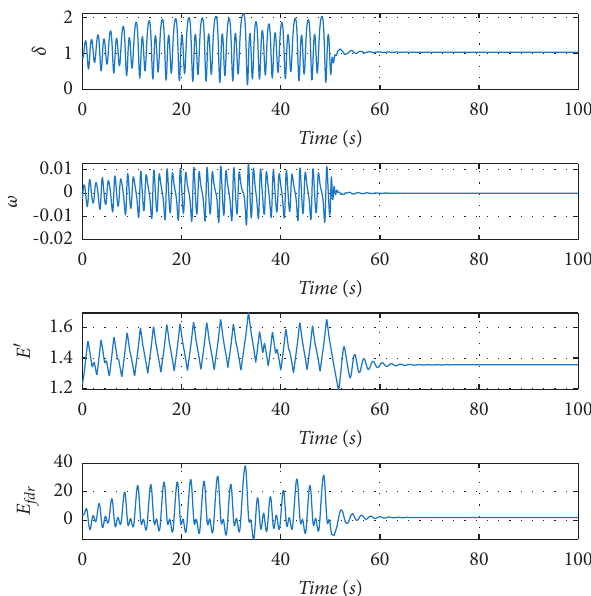
Figure 13: Time series responses for controlled fractional-order power system (31) with control in action at t � 50 ( s )